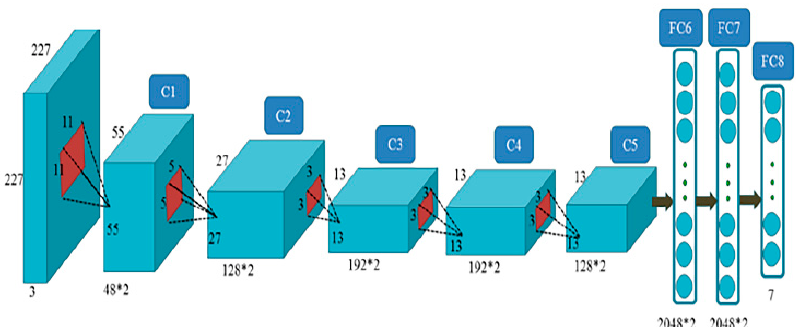
Figure 1. AlexNet network structure (* indicates multiplication).